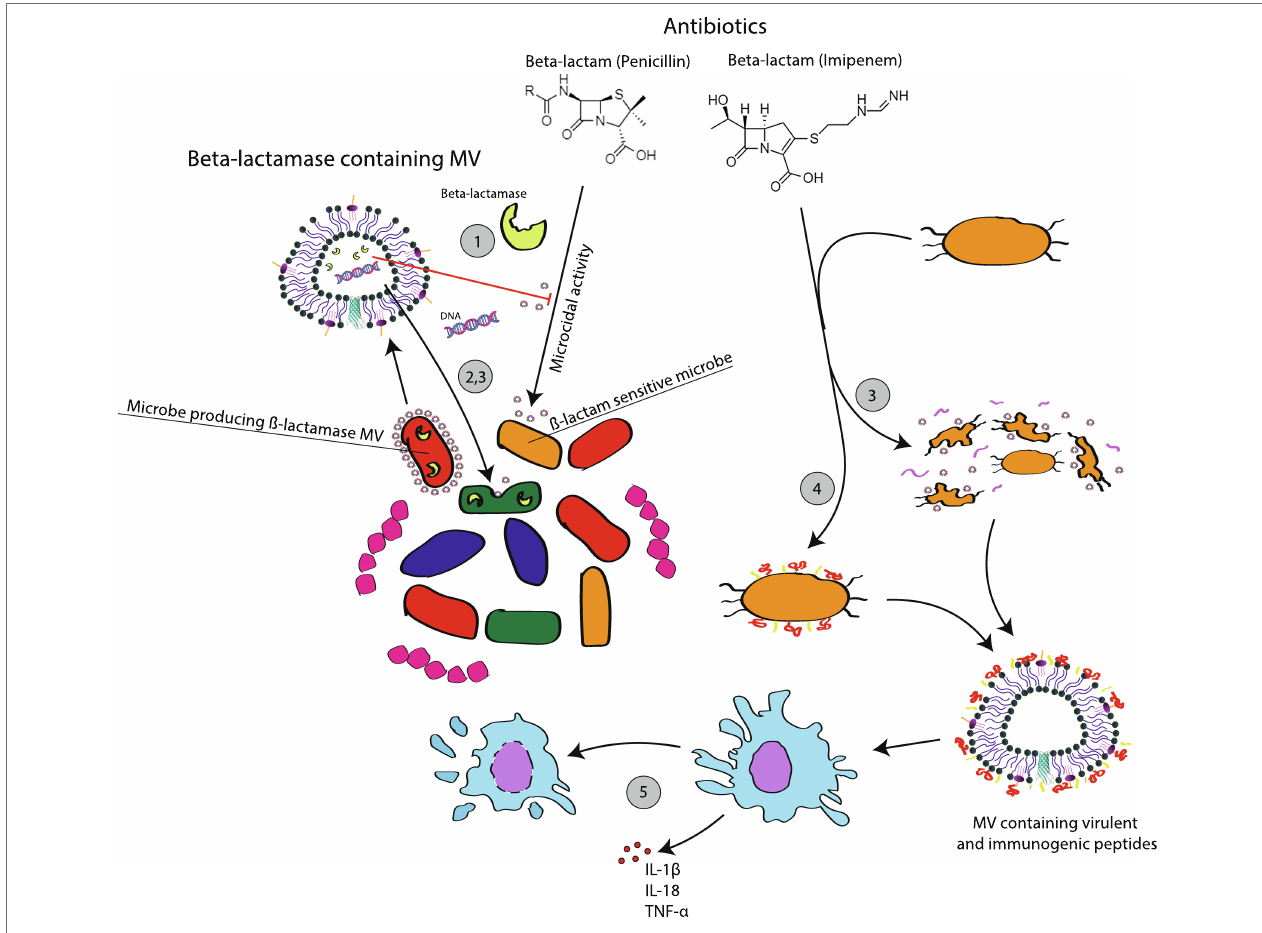
FIGURE 2 | Membrane vesicle mediated microbial responses to antibiotic usage. Following exposure to antibiotics, such as the ß-lactam examples used for this figure, many microbes will be induced to activate resistant traits including antibiotic degrading enzymes. MVs made by these bacteria can interfere with the effectiveness of antibiotics through several mechamisms: ß-lactamase containing MVs can directly degrade antibiotics in the surrounding environment, which will protect the host cell and susceptible neighboring cells; (1) ß-lactamase MVs uptaken by related microbial species will confer temporary protection for cells that now carrying the ß-lactamase enzyme without the ß-lactamase gene (2); MVs can carry plasmids encoding for ß-lactamase. Plasmids horizontally transferred to other cells will impart long term genetic immunity in recipient cells as they now produce their own ß-lactamase enzymes. (3) Protective benefits do not always depend on the presence of a protective enzyme. In some cases, antibiotic exposure triggers SOS responses, which result in MV formation through routes like bubbling cell death. This appears to assist bacteria in removing disruptive waste like cellular material damaged by antibiotics. The accumulation of MVs can also contribute to the formation of a biofilm, which can non-specifically shield persister cells and limit the diffusion of antibiotics (4). There are reports of antibiotics triggering the release of virulent MVs (5). In Klebsiella , MVs generated following exposure to imipenem appear to trigger phagocyte pyroptosis and the release of inflammatory mediators